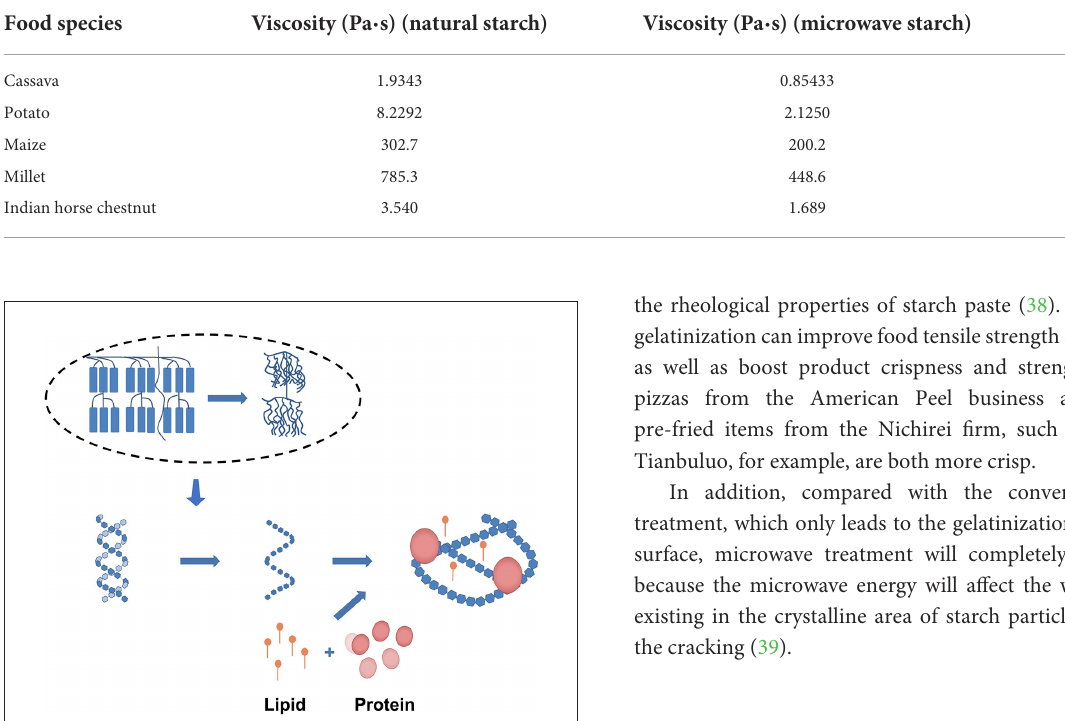
FIGURE6 Starch forms a complex with proteins and lipids.